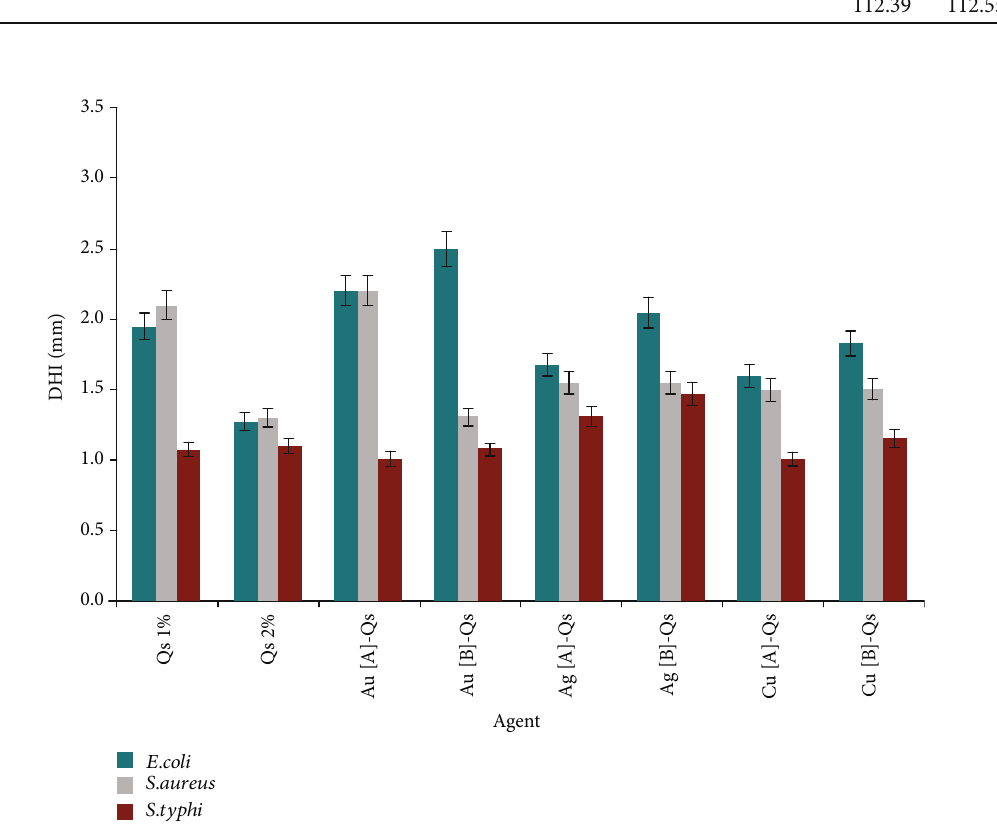
Figure 10: Diameter of inhibition zone (DHI) in disk di ff usion test of the formulations studied at 1% w/v suspended in 1% v/v acetic acid for cultures of E. coli , S. aureus , and S. Typhi